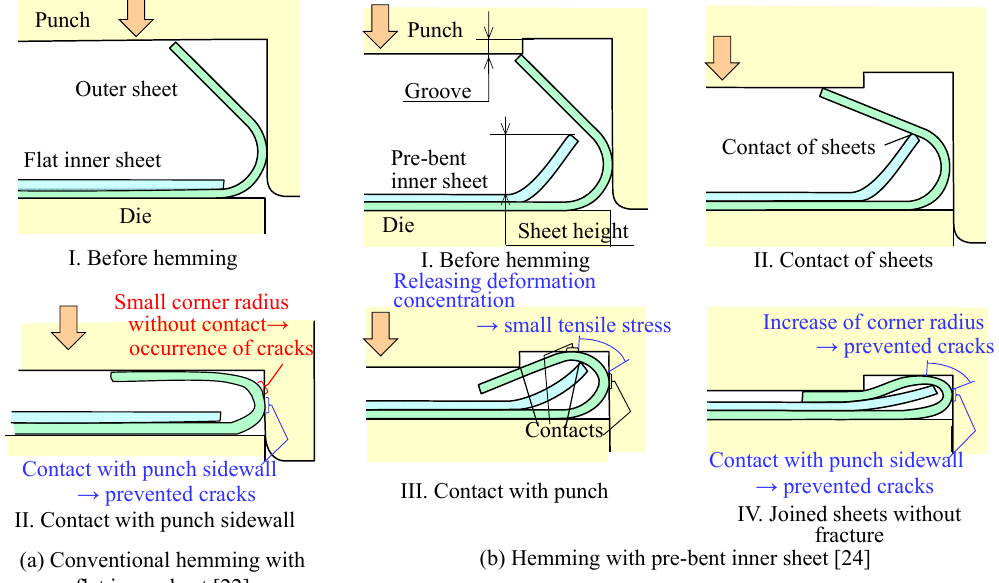
Figure 1. Prevention of crack in joining sheets by hemming with flat inner and pre-bent inner sheets [22,24].